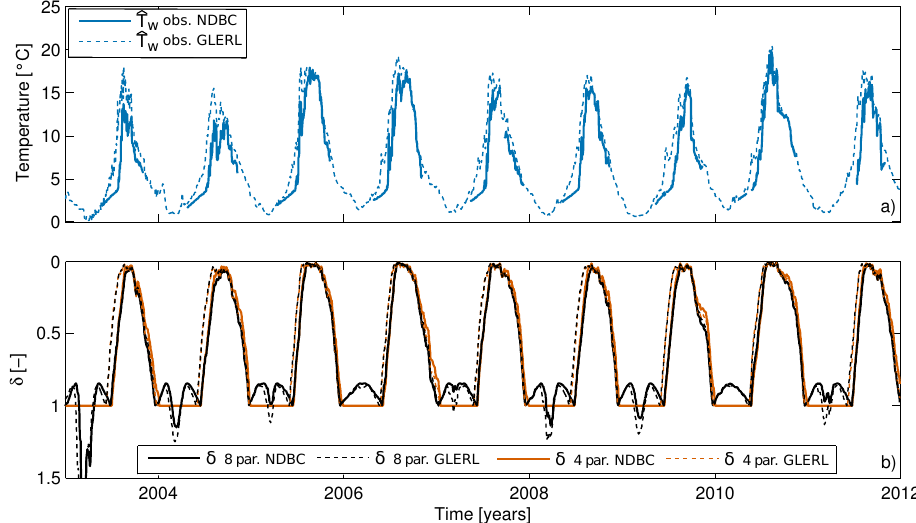
Fig. 8. Evolution of the dimensionless depth δ over the period 2003-2011: comparison between results for the full 8- and simplified 4- parameter versions of the model obtained from NDBC and GLERL simulations. a) Comparison of observed water temperature time series during the period 2003-2011 for the NDBC and GLERL dataset, respectively. b) Evolution of the dimensionless depth δ over the period 2003-2011 for the full 8- and simplified 4-parameter versions of the model (NDBC and GLERL simulations).